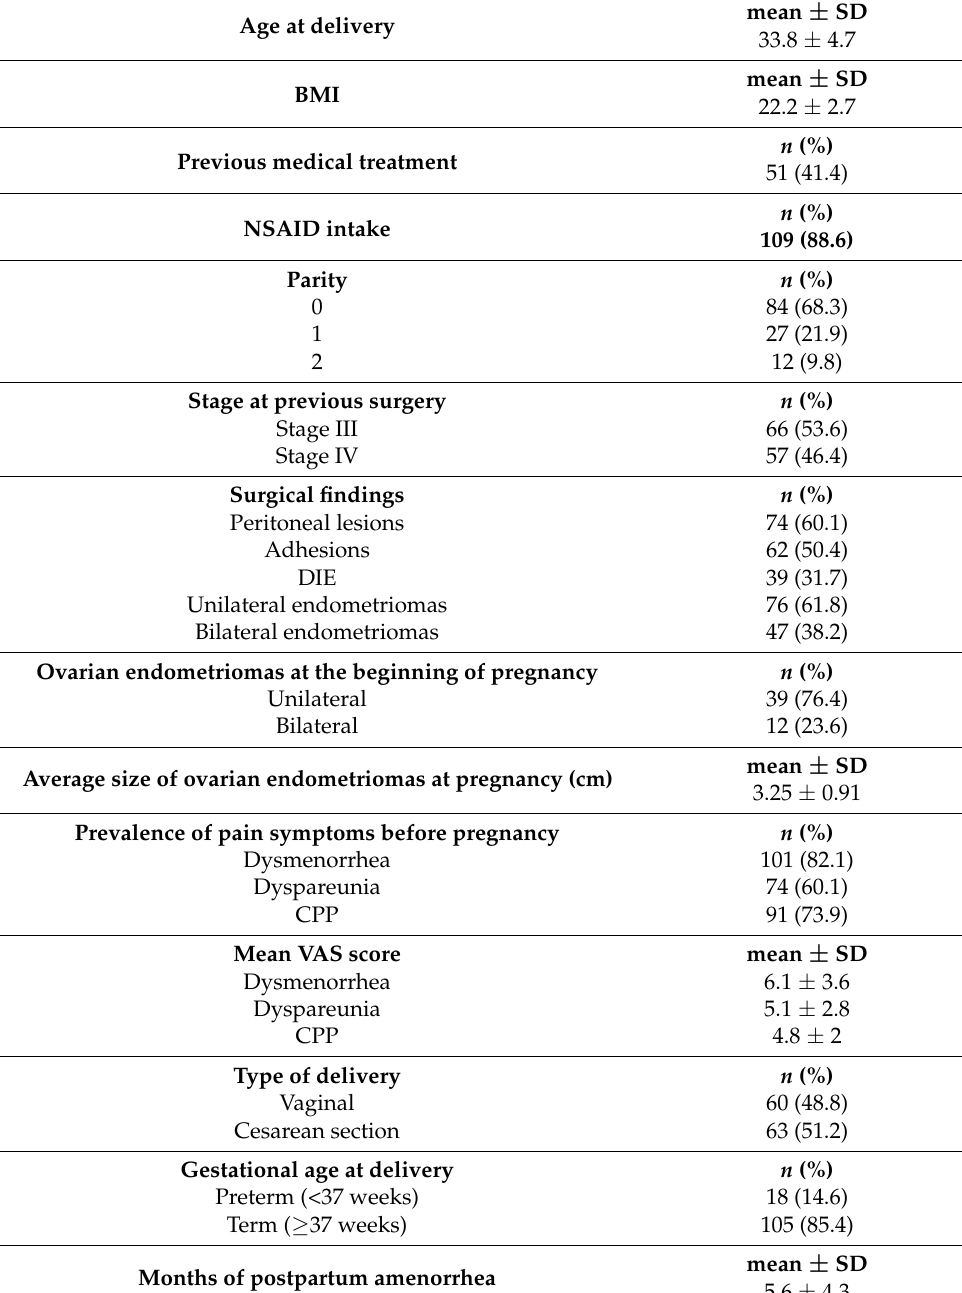
Table 1. General characteristics of the study